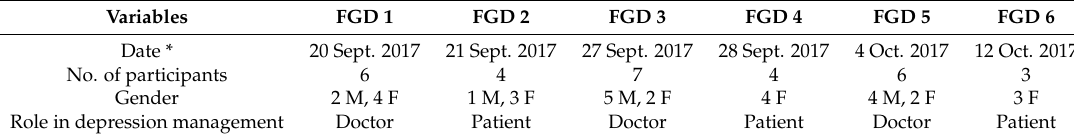
Table 1. Selected demographic characteristics ( n = 30) of each focus group discussion (FGD).